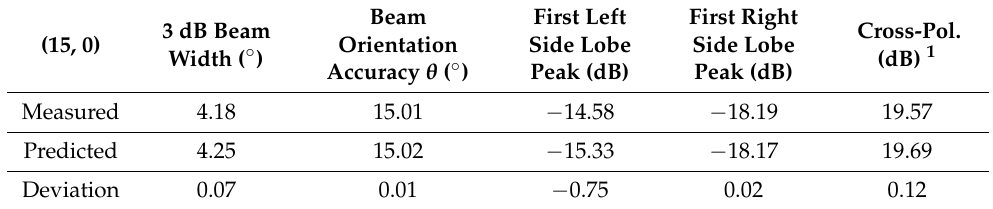
Figure 5. Comparison of predicted and measured beam profile at ( θ , φ ) = (30, 0). Table 1. Detailed factor comparison of predicted and measured beam profile at ( θ , ϕ ) = (15,